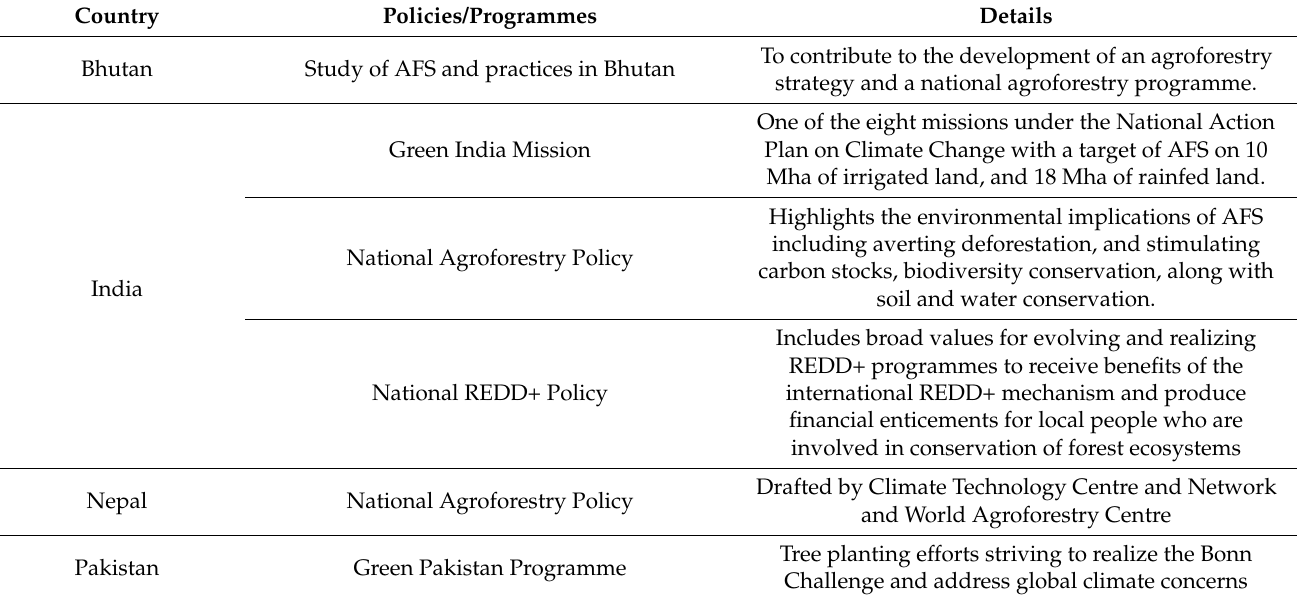
Table 7. Overview of policies and programmes for promoting Agroforestry system in South Asia Country Policies/Programmes